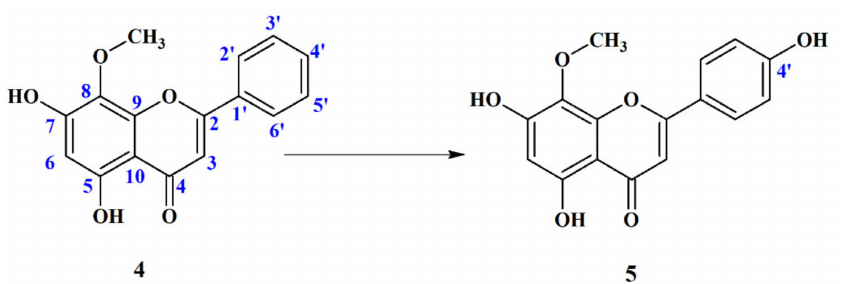
Figure 6. Biotranformation of wogonin ( 4 ) to 4 (cid:48) -hydroxywogonin ( 5 ) by: Absidia cylindrospora